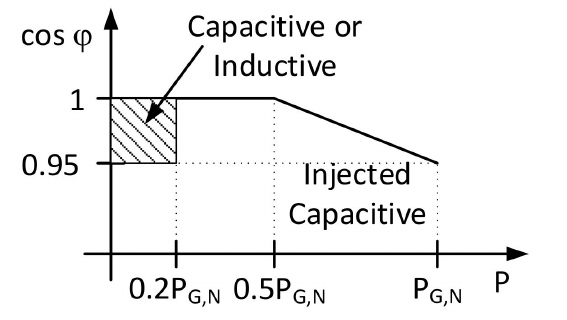
Figure 4. Power factor cos ( ϕ G ) as a function of the active power injected into the